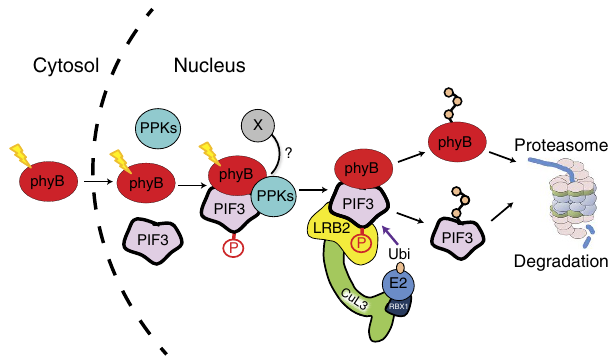
Figure 7 | Model depicting proposed mechanism of light-induced PIF3 phosphorylation. Photoactivated phyB translocates rapidly into the nucleus and forms a trimolecular complex with PIF3 and one or more PPKs, which catalyse multisite transphosphorylation of PIF3. The LRB Cullin 3 E3 ligases then recognize phosphorylated PIF3, triggering concurrent ubiquitination and degradation of both PIF3 and phyB. X: potential additional factor contributing to Pfr-induced PIF3 phosphorylation in vivo , but missing from in vitro kinase assays performed blue-light photoreceptor CRY2 (ref. 34). Thus, the PPKs appear to have evolved with the potential to function in coordinating the activities of the circadian, red-light and blue-light photosensory pathways in plants through participation as components of dynamically changing multimolecular complexes.